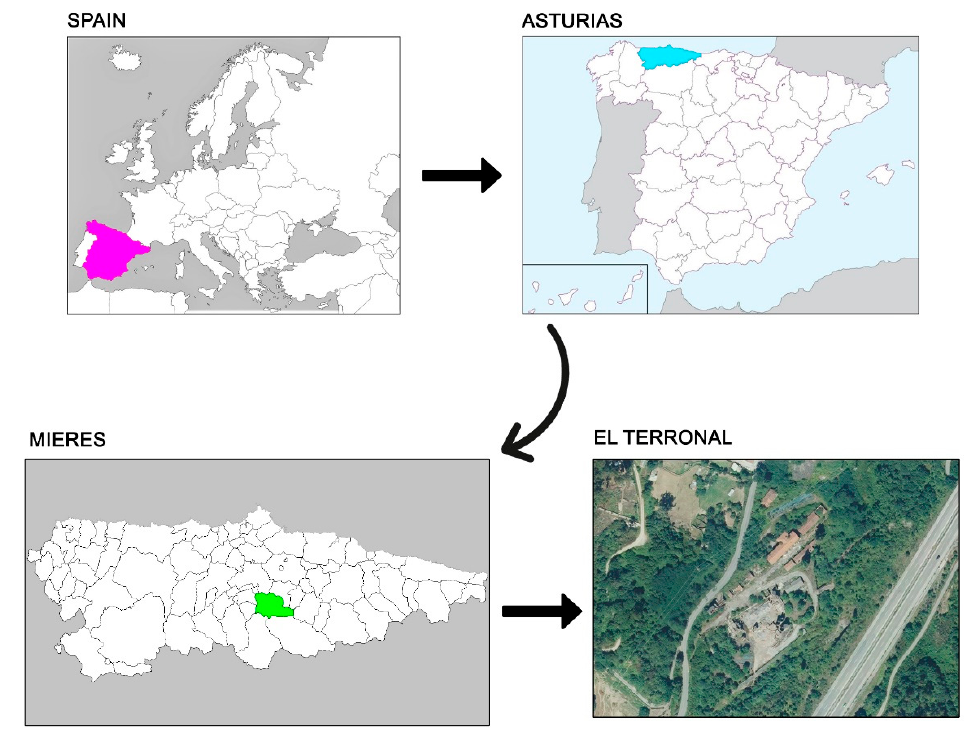
Figure 1. “El Terronal” study area location and an aerial view of the site.